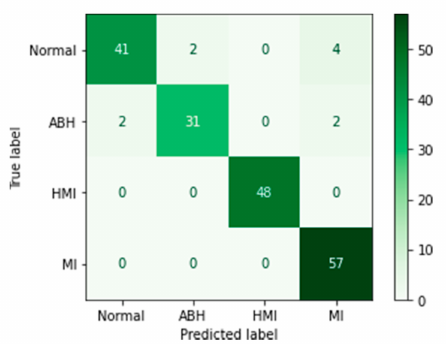
Figure 7. Confusion matrix for the VGG16